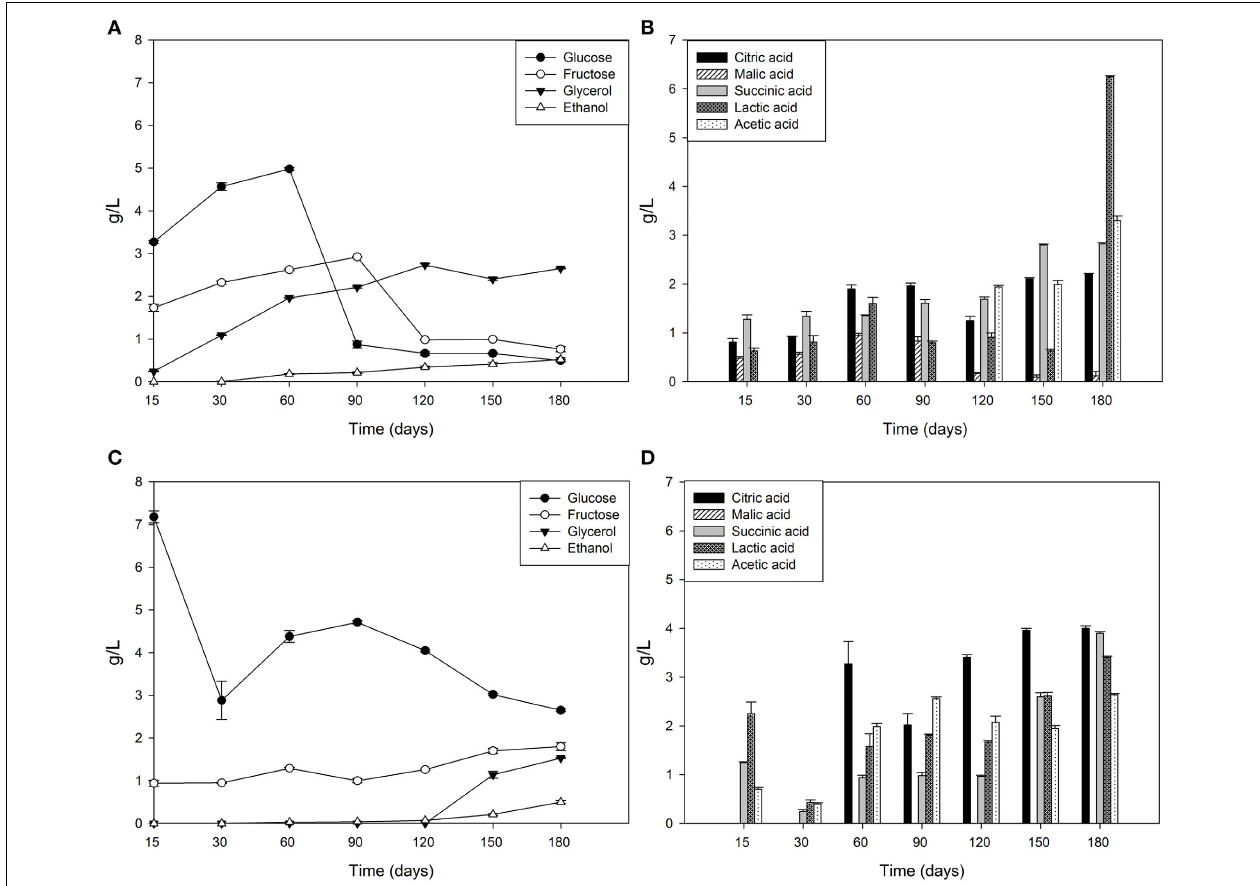
FIGURE 3 | Sugar, organic acid and alcohol evolution in Cellina di Nardò (A,B) and Leccino (C,D) brines during natural fermentation process.